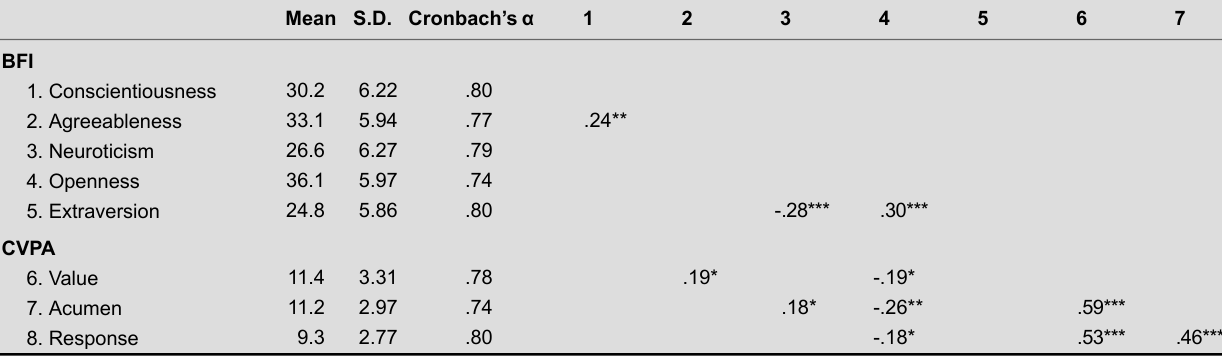
Univariate Descriptive Statistics, Internal Consistencies and Bivariate Correlation